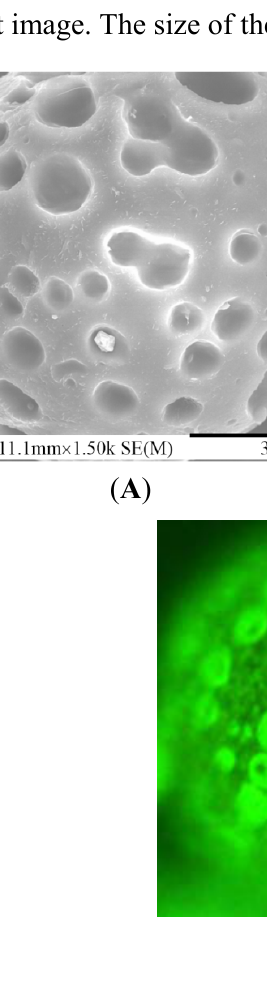
Figure 7. PL spectra obtained from as-prepared CdSe/ZnS-TOPO QDs (solid line) and CdSe/ZnS-TOPO QDs-loaded PLGA microparticles (dotted